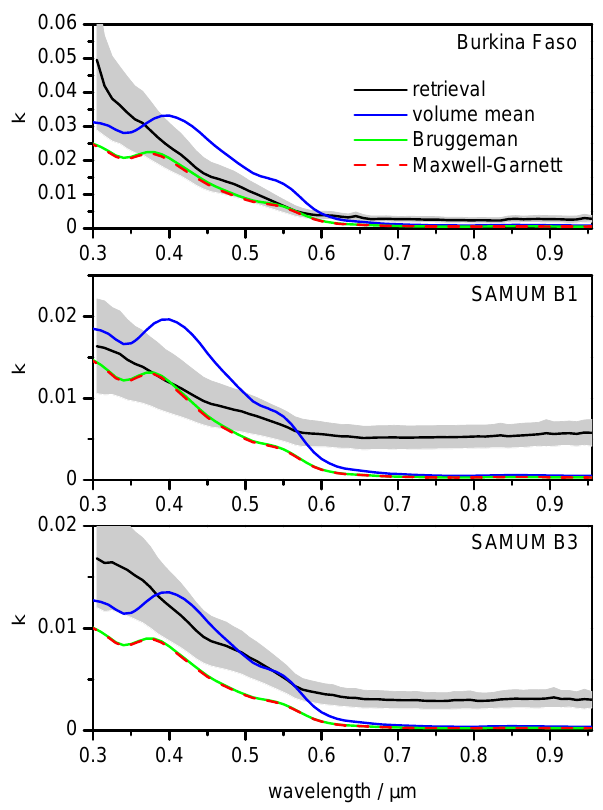
Fig. 13. Comparison of the retrieved k spectra for the dispersed Burkina Faso, SAMUM B1, and SAMUM B3 soil samples (the shaded areas represent the errors from Table 5) with those computed with various mixing rule approaches (volume mean, Bruggeman, and Maxwell-Garnett approximation; see Sokolik and Toon, 1999), employing the hematite volume abundances derived from the single particle analyses of the mineralogical composition (Table 4). See text for